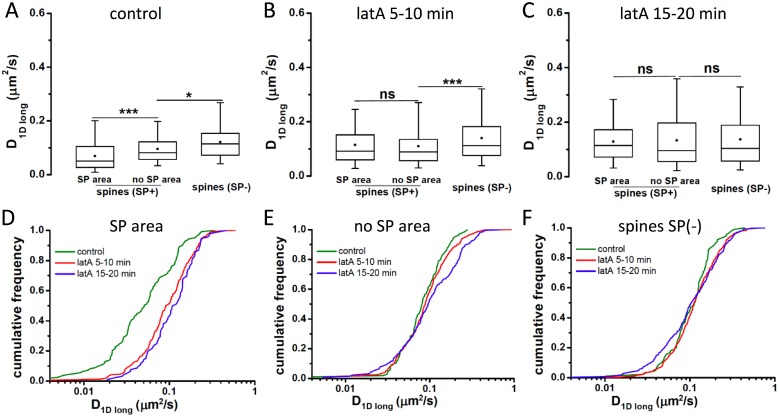
Effect of actin depolymerisation on mGluR5 diffusion.(A-C) Diffusion coefficients D1Dlong of pHluorin-mGluR5 in spine necks under control conditions (A, same data as in Fig 3F), during 5–10 min (B) and 15–20 min (C) of latrunculin A exposure (n ≥ 89 trajectories from 3–5 cultures; Table E in S1 File). (D) Direct comparison of the data shown in A-C shows that the diffusion coefficients within SP domains of the spine neck increase during 5 μM latA application. (E,F) No drastic changes in diffusion occur in SP-negative regions of the spine neck (E) and in SP- spines (F) during latA treatment.